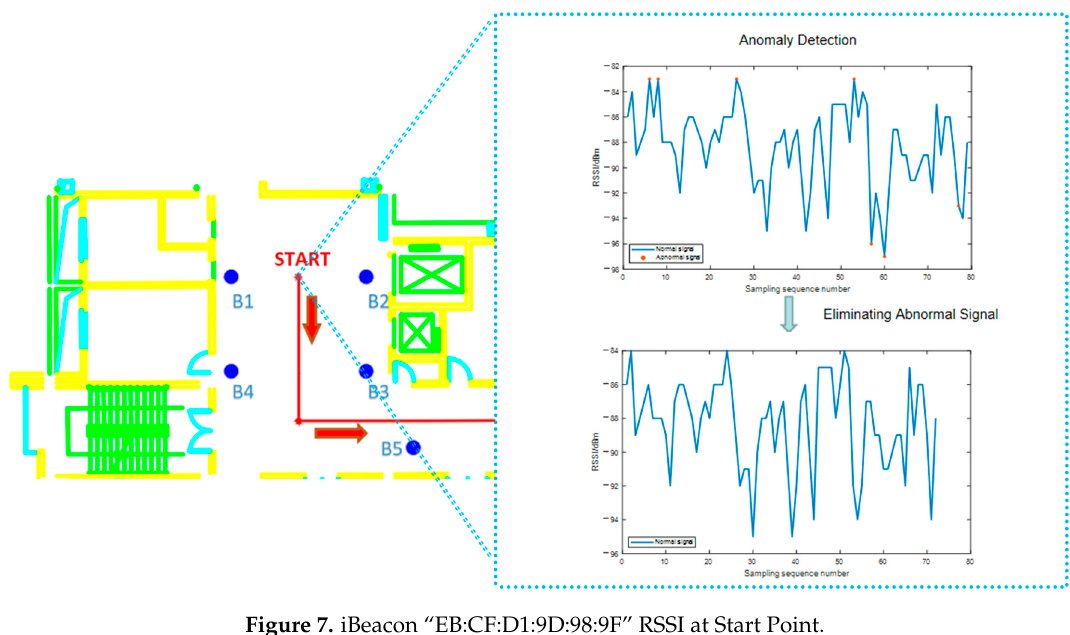
Figure 7. iBeacon “EB:CF:D1:9D:98:9F” RSSI at Start Point.